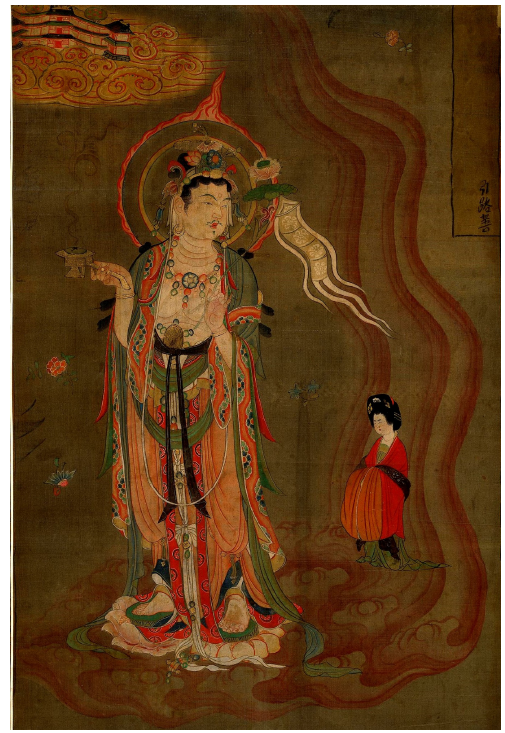
Figure 12. Soul-Guiding Bodhisattva . Dunhuang, 9th century. Ink and colors on silk, 80.5 × 53.8